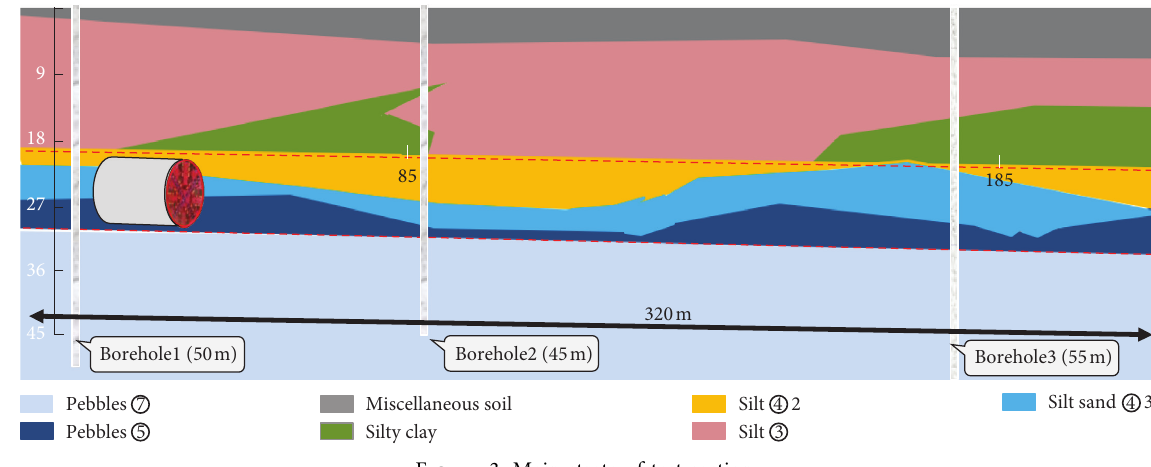
Figure 3: Main strata of test section. Table 2: Physical and mechanical indicators of main crossing soil layer in test section.